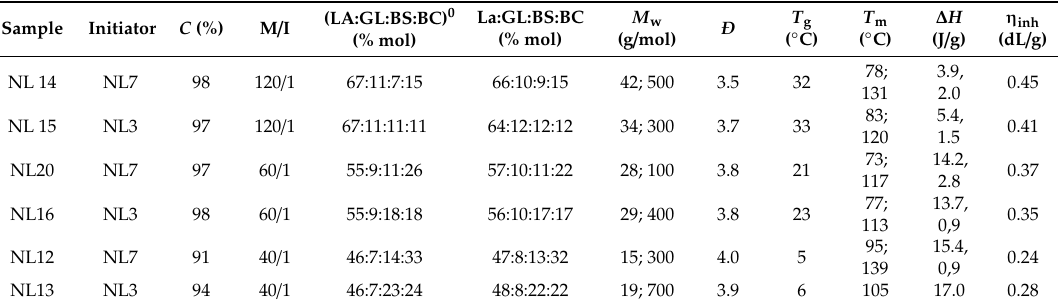
Table 4. Characteristics of synthesized poly ( l -lactide– co –glycolide)– block –(butylene succinate– co – butylene citrate).